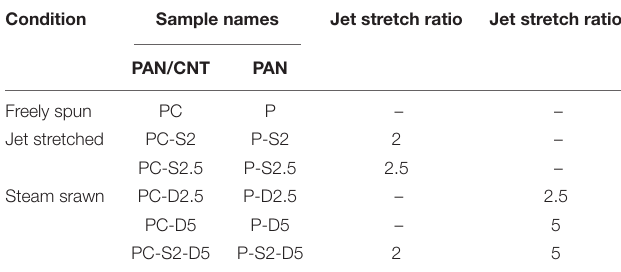
FIGURE 2 | Schematic diagram of the steam drawing chamber used in this research. TABLE 1 | Denotation and production conditions of PAN/CNT and PAN fibers.